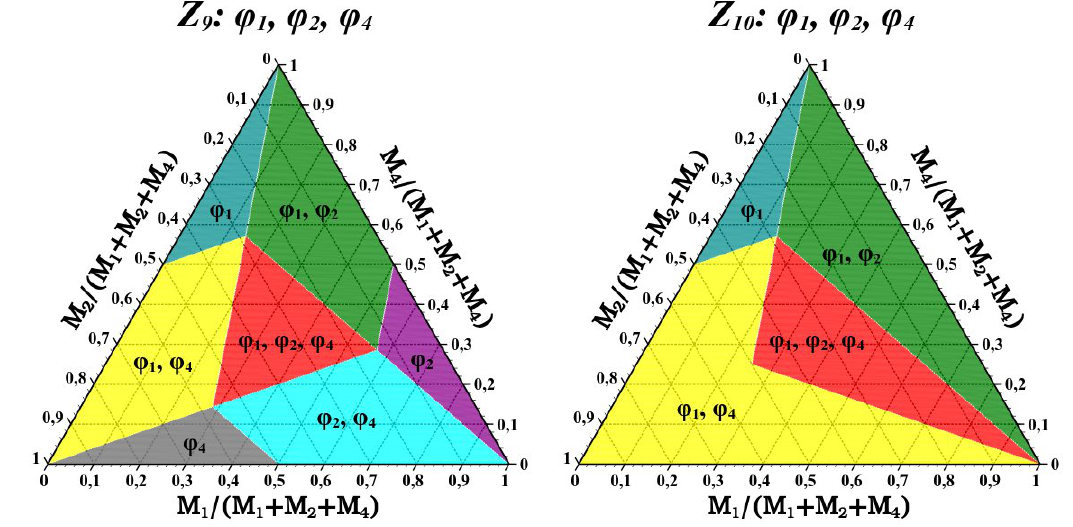
Figure 3 . Stability regions for a Z 9 (left panel) and Z 10 (right panel) symmetry with